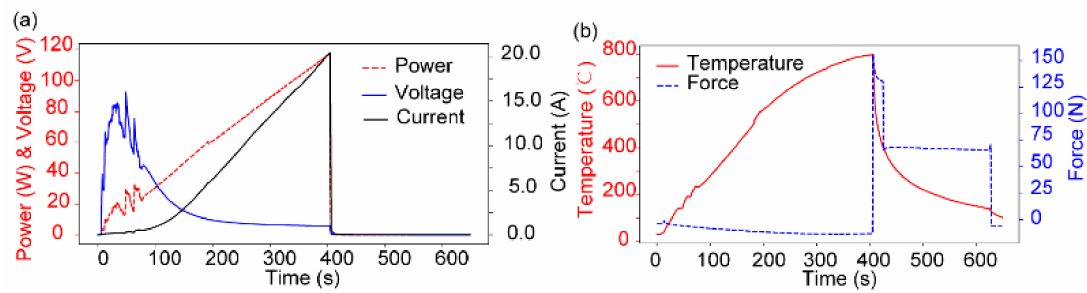
Figure 8. Time history plots of process parameters: ( a ) applied voltage, current and power, ( b ) temperature of silicon mold and applied